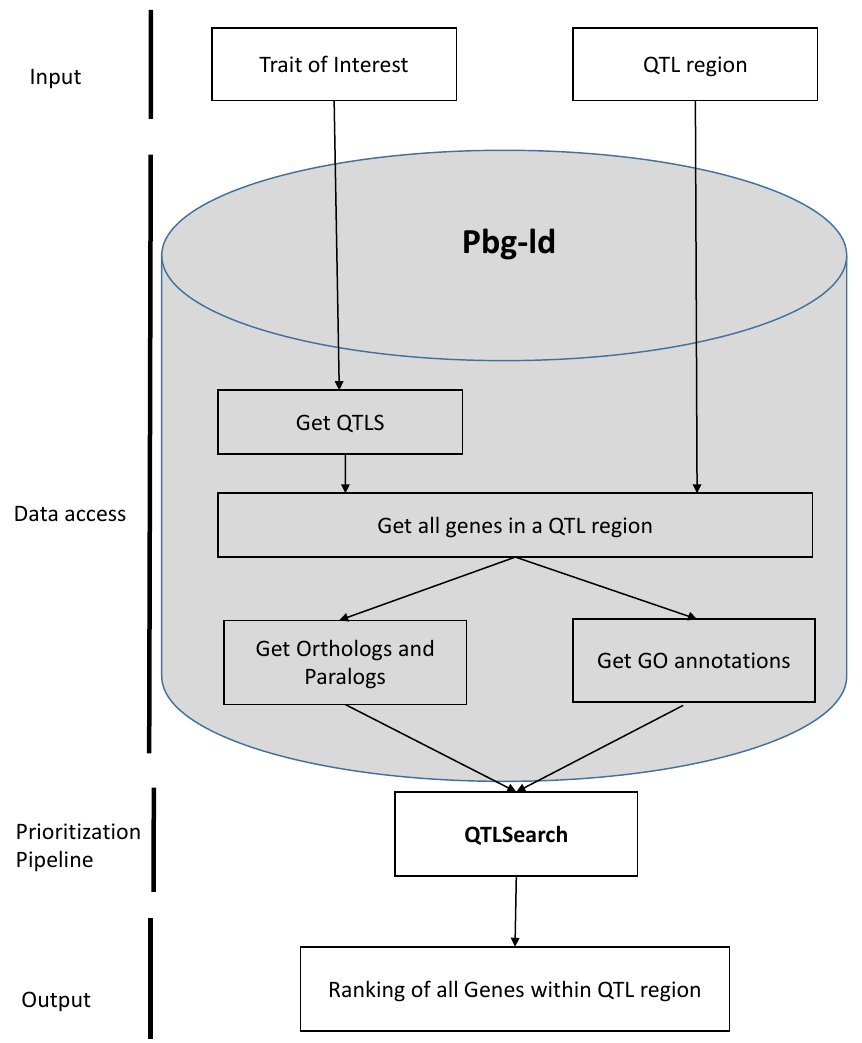
Figure 7. A workflow to predict candidate genes in a QTL region for the traits of